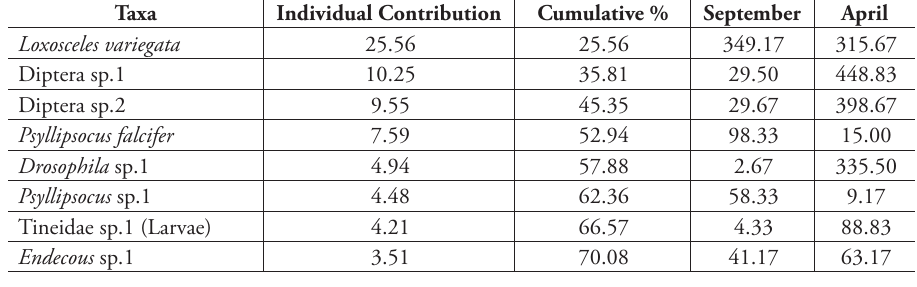
Table 4. SIMPER analysis. Species that mostly contributed to dissimilarity presented by deep sectors in both sampling events.